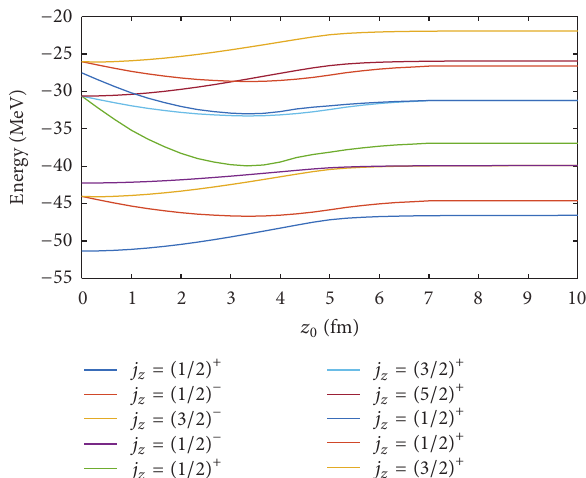
Figure 6: Variations of the eigenvalues ( 𝑛 𝑧 , 𝑛 𝜌 , 𝑚 ) in 𝑧 -axis includ- ing spin-orbit coupling with the distance between the two cluster